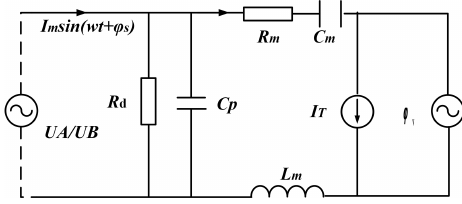
Figure 3. Equivalent circuit of the piezoelectric ceramics (one